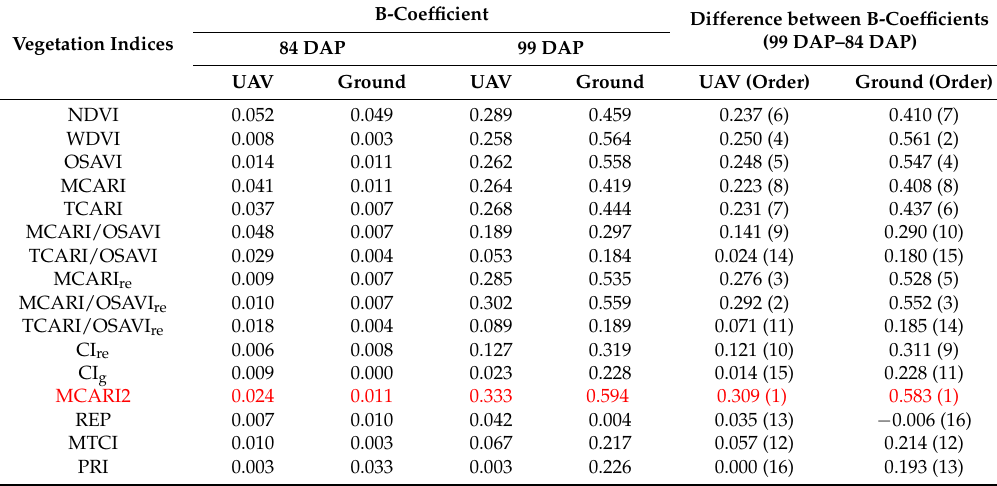
Table A2. Bhattacharyya coefficient (B-coefficient) between distributions of vegetation indices, calculated from UAV and ground-based measurements, corresponding to each production system (i.e., non-mixed and mixed varieties). Only values calculated for the two last data acquisitions (84 and 99 days after planting – DAP) are presented. The index giving the best treatments distinction (i.e., largest B-coefficients) for both sensor systems is indicated in red.